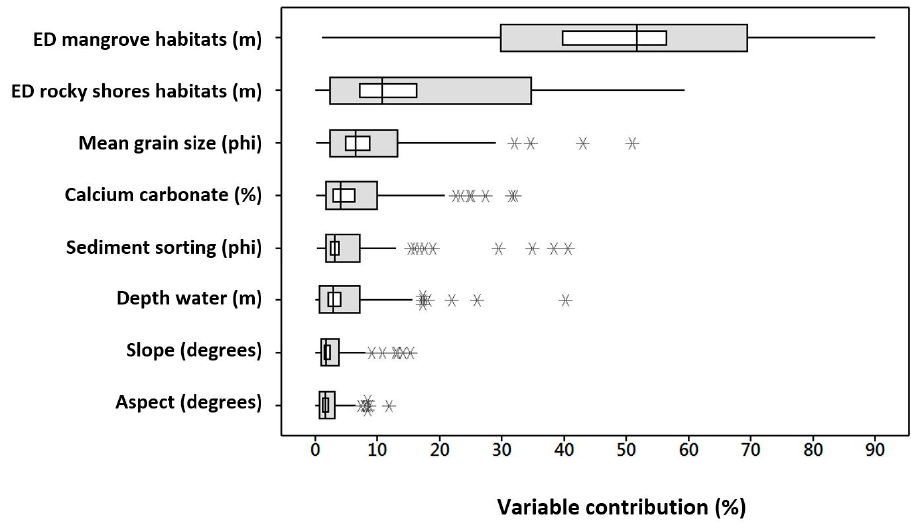
Figure 2. Relative contribution (%) of the environmental layers (variables) to MaxEnt models based on the 108 species. ED = Euclidean distance from specific habitats. ED mangrove and rocky shores habitats are the main variables for abiotically suitable areas predictions.